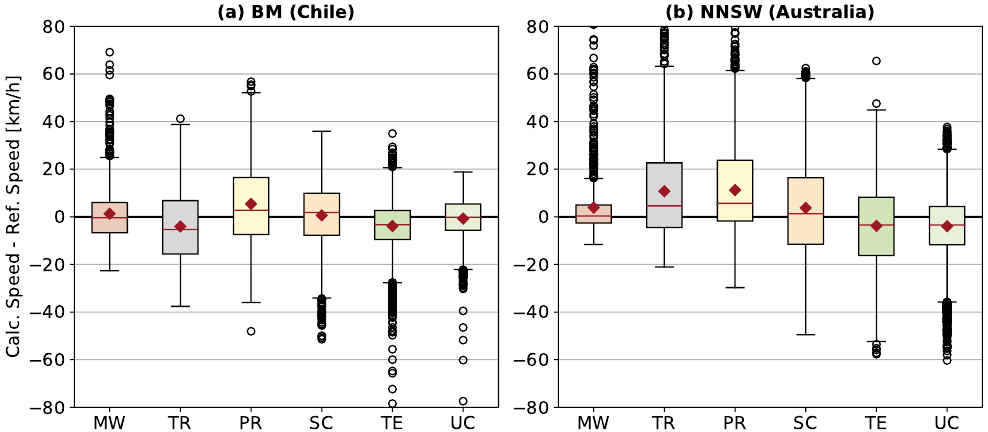
Figure 7. Boxplots of the distribution of the difference between calculated speeds and the GD-API reference speed data per road class in ( a ) the BM regions and ( b ) NNSW. Both OSM and SRTM are used as input data. Negative values signify lower estimated speed values than reference speed values. Road classes: MW— Motorway , TR— Trunk , PR— Primary , SC— Secondary , TE— Tertiary , UC— Unclassified . The red diamonds in the boxes symbolize the respective median, the red lines the respective mean value. The lower limit of each box is the 25 th percentile ( Q 1), the upper limit the 75 th percentile ( Q 3) so that the difference builds the interquartile range ( IQR ). Whiskers extend to Q 1 − 1.5 ∗ IQR and Q 3 + 1.5 ∗ IQR . Any points beyond the whiskers are outliers and are plotted as